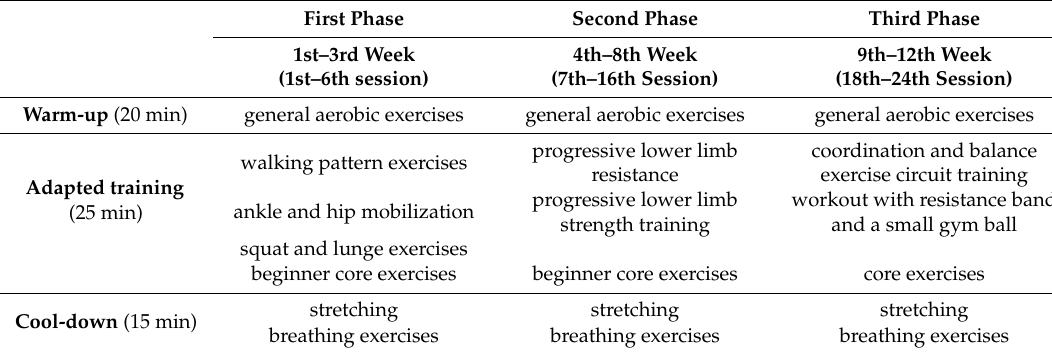
Table 1. Description of the twelve-week adapted fitness (AF)